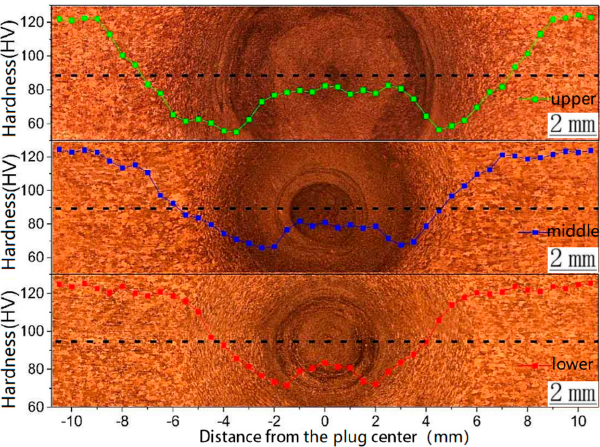
Figure 9. Hardness distribution of FPW joint.